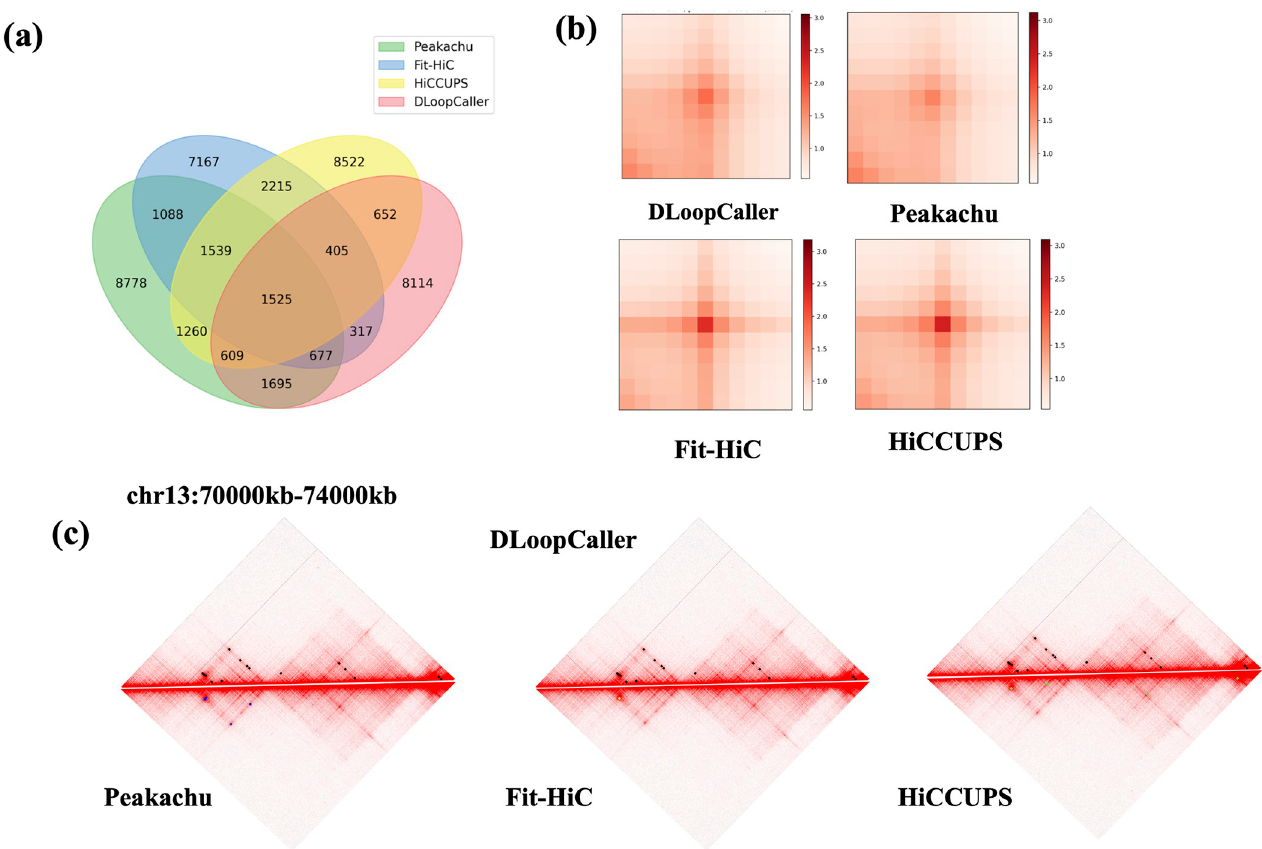
Fig 5. Comparison of chromatin loops identified by DLoopCaller, HiCCUPS, Fit-HiC, and Peakachu in GM12878. (a) Venn diagram of identified chromatin loops determined by DLoopCaller CTCF ChIA-PET, HiCCUPS, Fit-HiC, and Peakachu in GM12878. (b) APA plots for DLoopCaller CTCF ChIA-PET loops, HiCCUPS, Fit-HiC, and Peakachu in GM12878. (c) A visual example of identified loops by different models in a region. The black dots in the upper half of the three diamond-shaped graphs represent the chromatin loops identified by DLoopCaller, and the blue, green, and yellow dots in the lower half represent the chromatin loops identified by Peakachu, Fit-HiC, and HiCCUPS